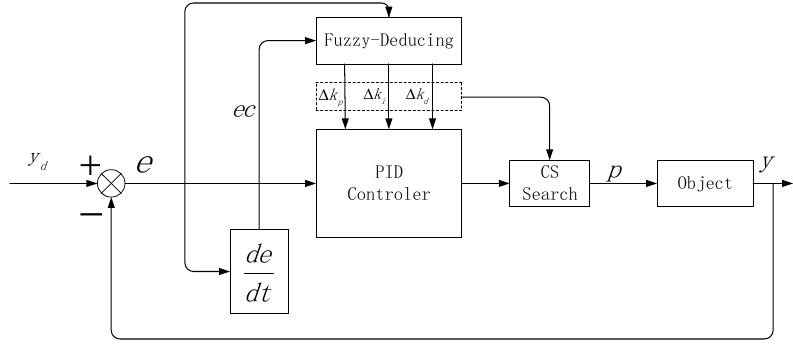
Figure 5. CFPID controller model.